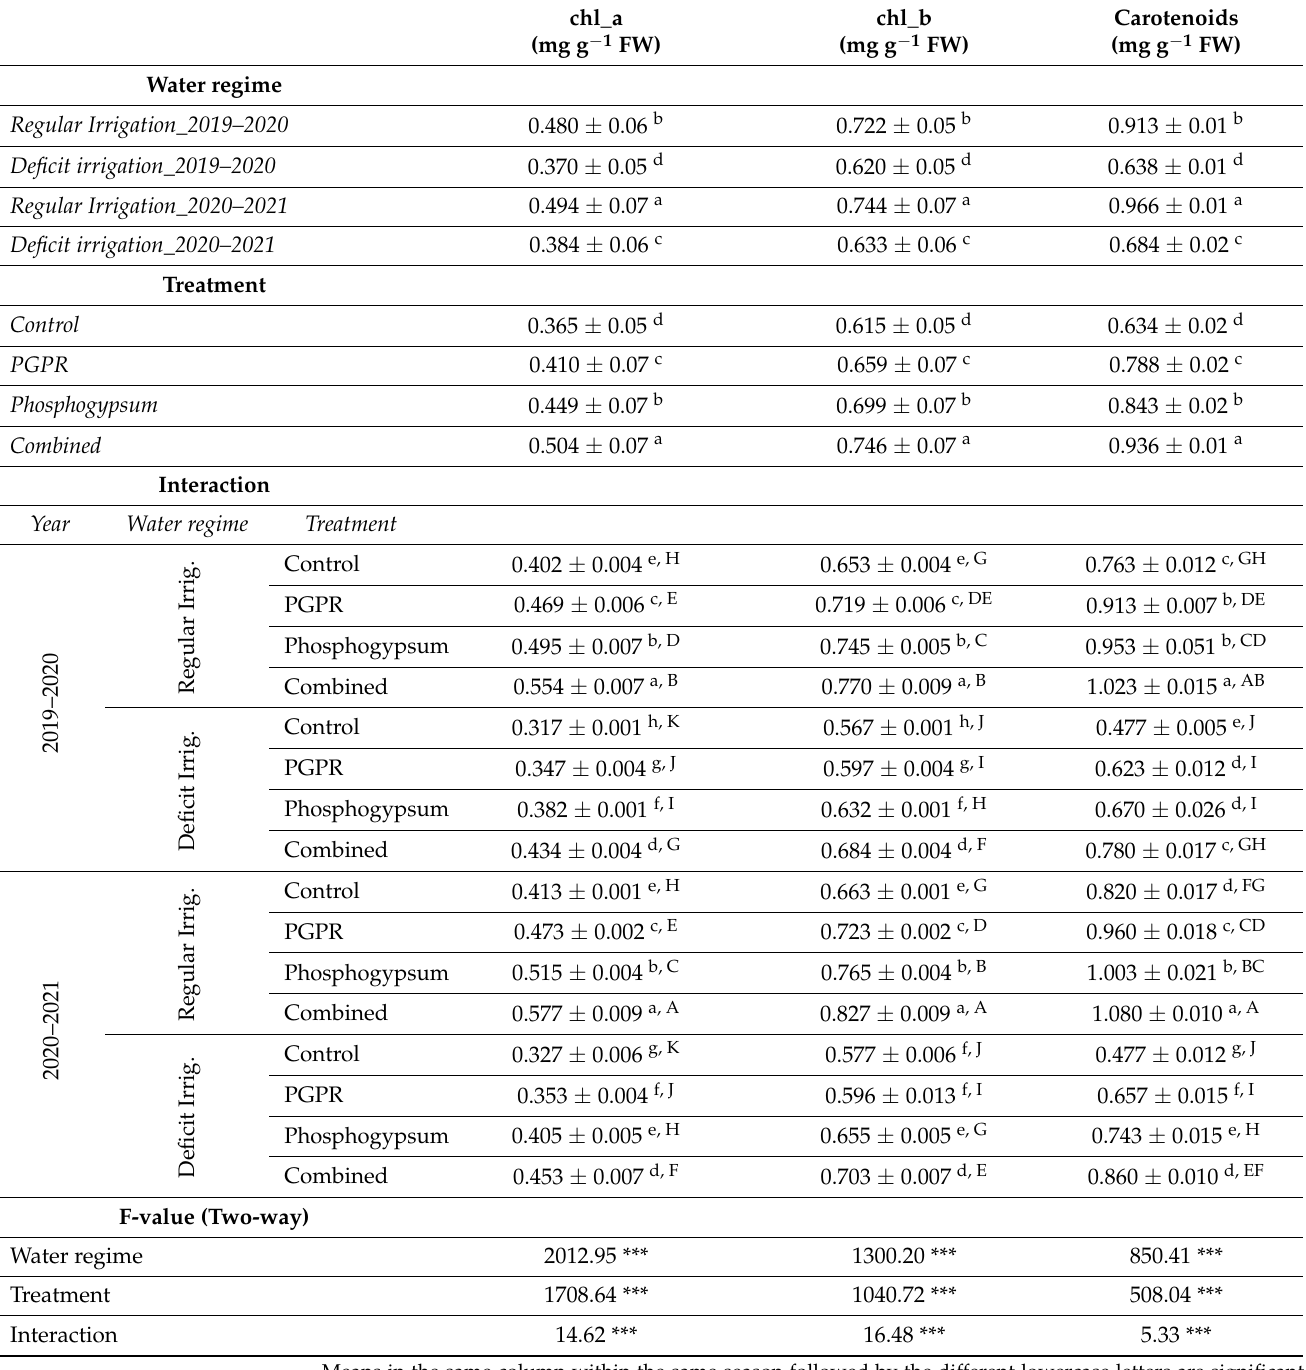
Table 3. Contents of photosynthetic pigments in quinoa leaves grown in the presence of different water regimes and treated with phosphogypsum, plant growth-promoting rhizobacteria, or